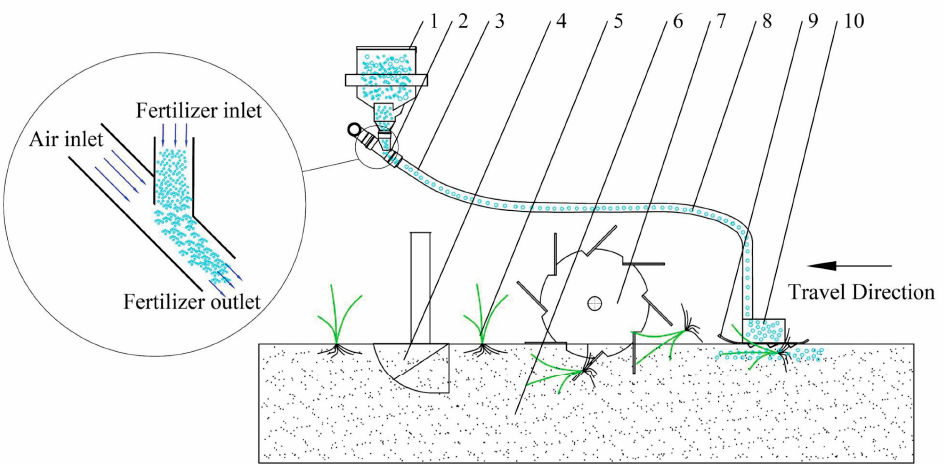
Figure 2. Working principle of RFW machine. 1. Fertilizer box; 2. Air–fertilizer mixing chamber; 3. Pipe; 4. Furrower; 5. Weeds; 6. Soil; 7. Weeding wheel; 8. Fertilizer; 9. Depth-limiting plate; 10. Fertilizer tank.